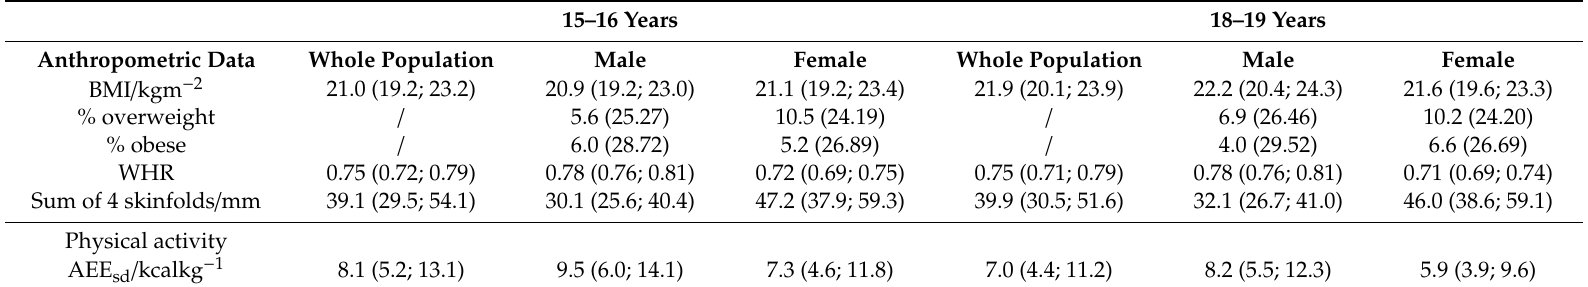
Table 4. Sample anthropometric and physical activity data depending on age and gender of